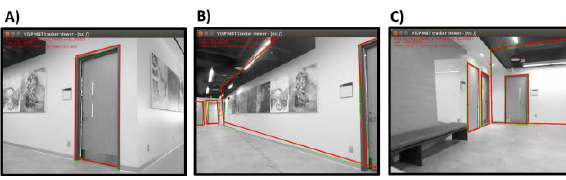
Figure 1. Sample frames demonstrating the ViSP model-based tracker. The second floor of York University’s Bergeron onto the image plane (red lines) using the previous